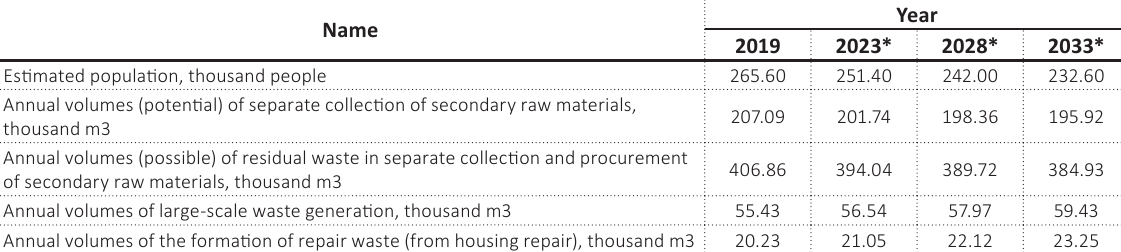
Table 1. Volumes of solid waste in Sumy